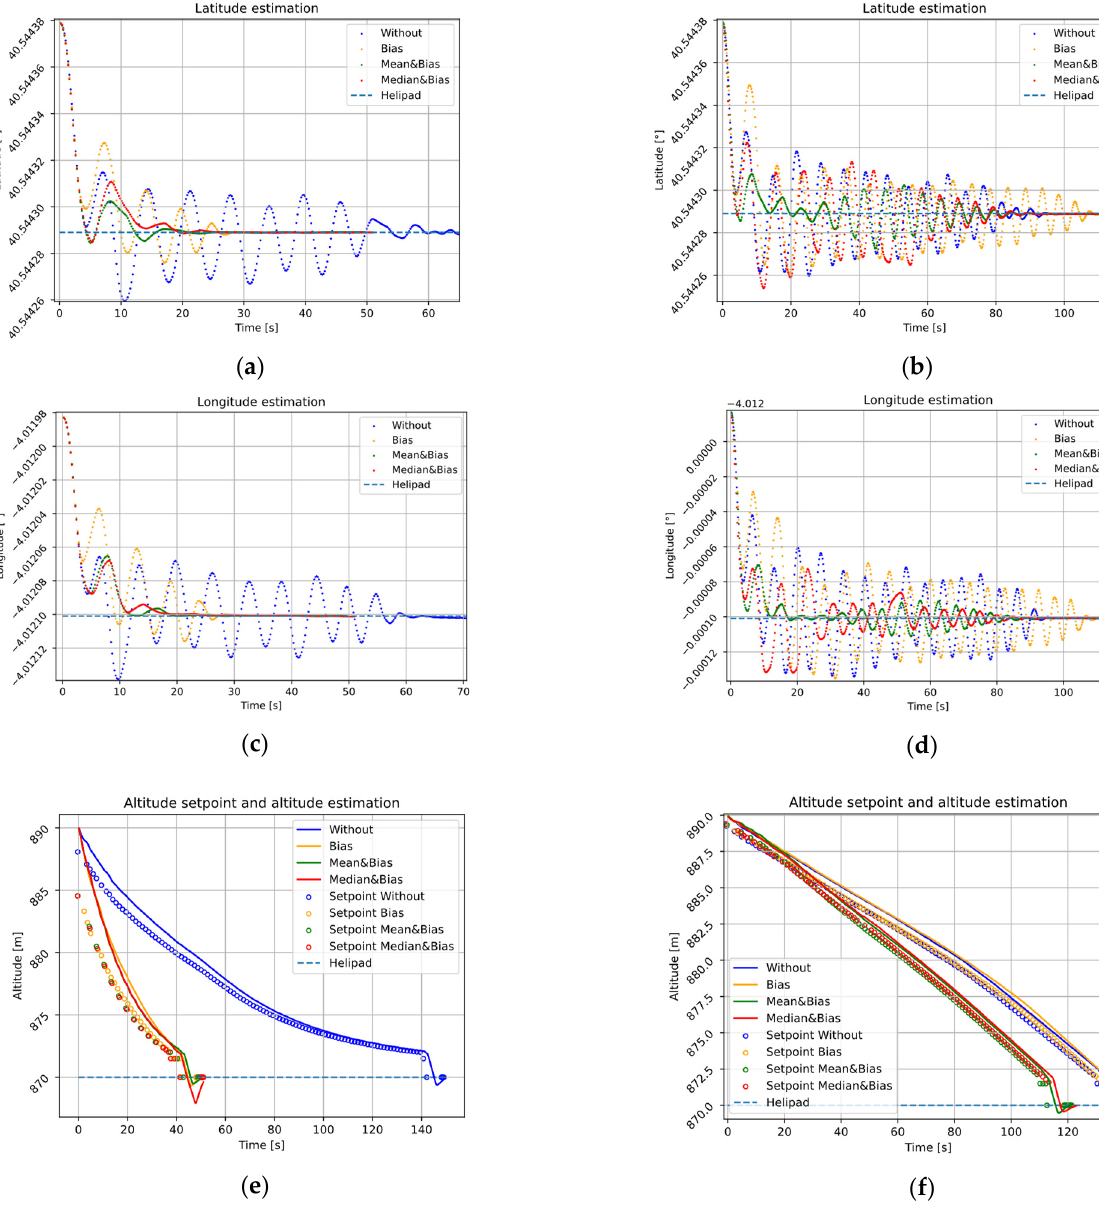
proposal and linear descending.